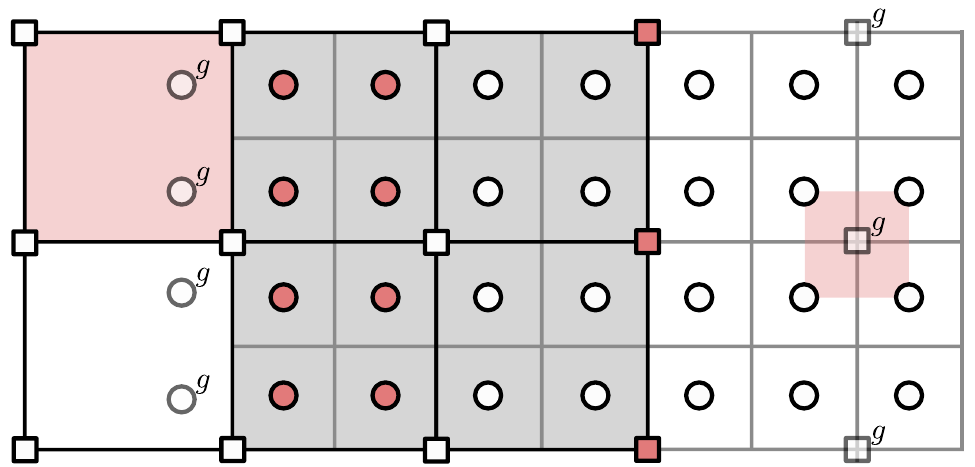
Figure 8. Grid transition interface for two-dimensional combined grid layout including coarse g g and fine ghost nodes needed for central-difference approximation of velocity gradients during HRR collision at coarse and fine interface nodes , respectively, light-red area indicates validity range of velocity interpolation function